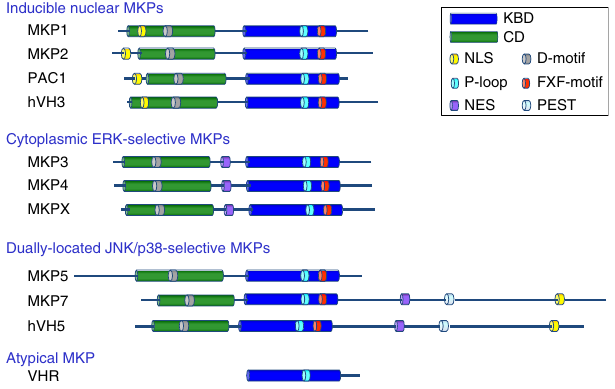
Figure 1 | Domain structures of ten human MKPs and the atypical